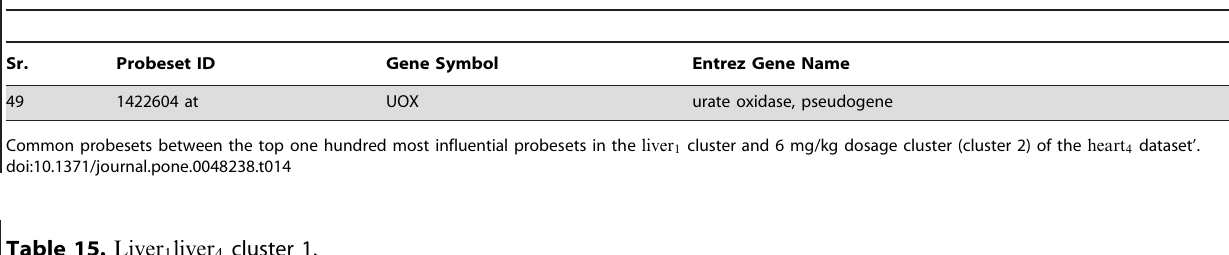
Table 15. Liver 1 liver 4 cluster 1.